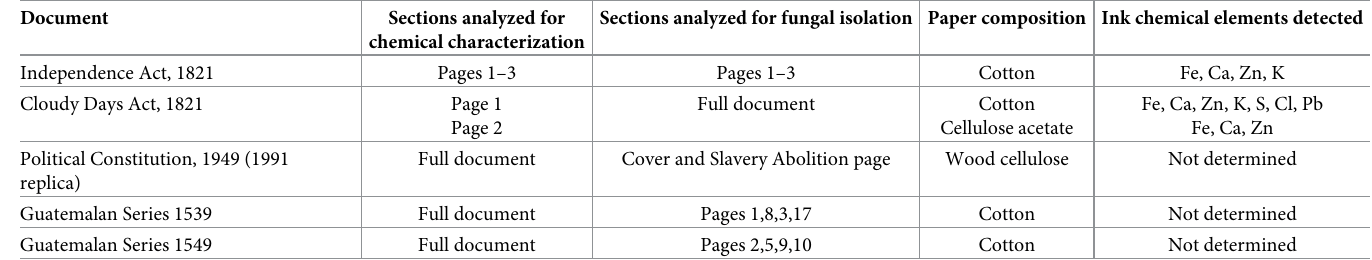
Table 1. Chemical, substrate, and ink characterization of the historic documents from Costa Rica. See S2 Table for measurements of iron and calcium percentages. Sections analyzed for Sections analyzed for fungal isolation Paper composition Ink chemical elements chemical characterization